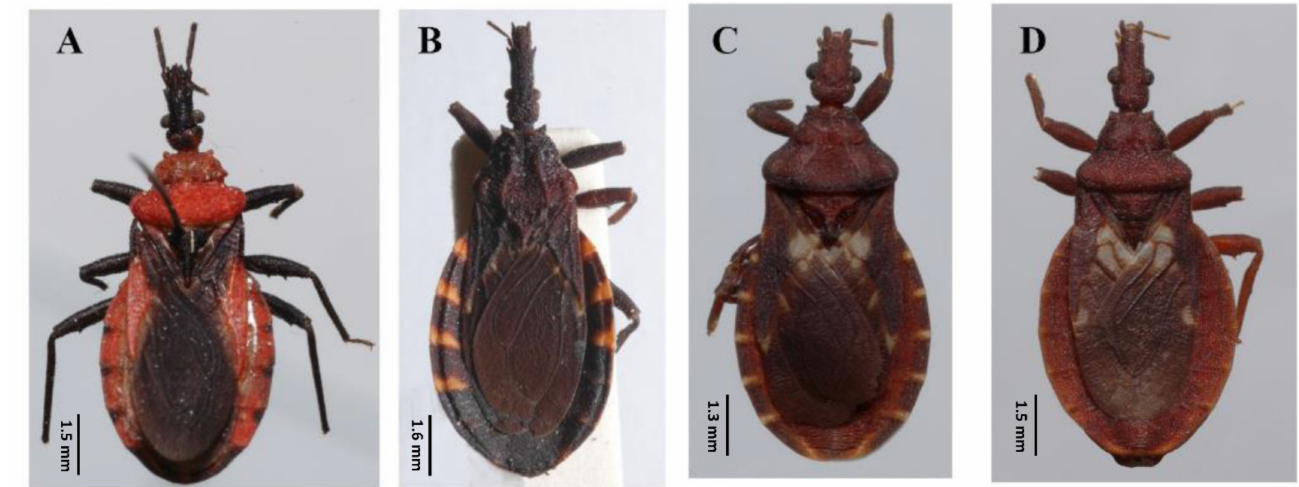
Figure 1. Tribe Bolboderini genera: ( A ) Bolbodera Vald é s, 1910 (female specimen of Bolbodera scabrosa Vald é s, 1910); ( B ) Belminus Stål, 1859 (female specimen of Belminus peruvianus Herrer, Lent and Wygodzinsky, 1954); ( C ) Microtriatoma Prosen and Mart í nez, 1952 (male specimen of Microtriatoma borbai Lent and Wygodzinsky, 1979); ( D ) Parabelminus Lent, 1943 (male specimen of Parabelminus carioca Lent, 1943). All specimens are deposited in the Triatominae collection (CTIOC), Oswaldo Cruz Institute, Fiocruz,